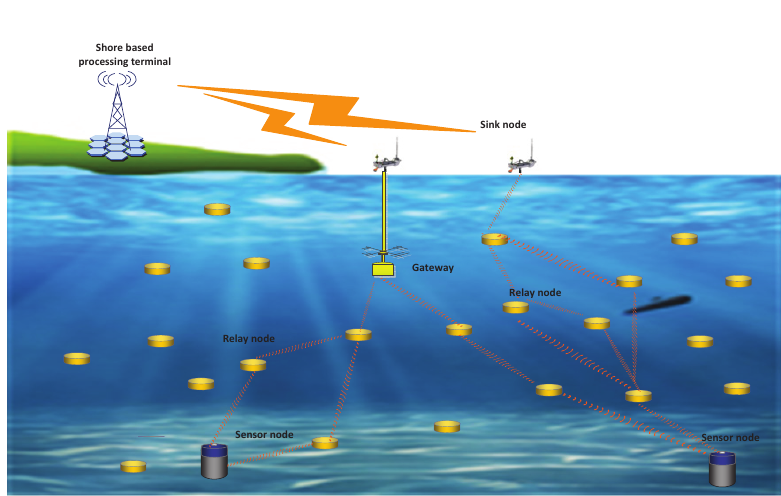
Figure 1. 3D network